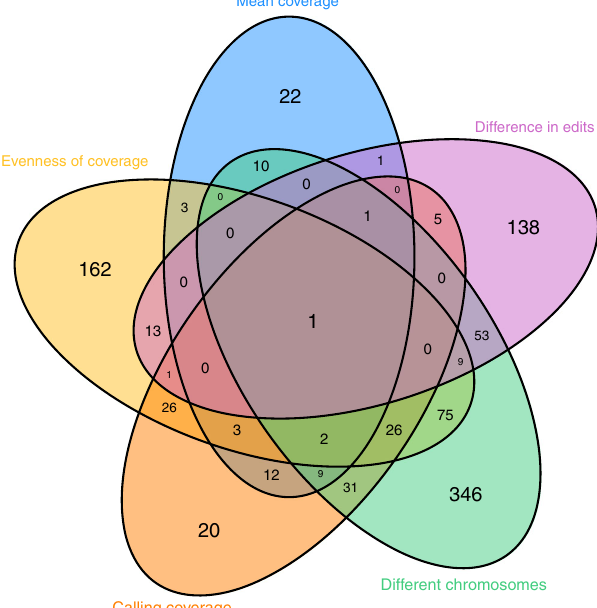
Fig. 2 Venn diagram showing for which QC measure sample pairs were penalised for. The outside numbers show the number of sample pairs which fail that QC measure uniquely. The intersections show the number of sample pairs that have failed more than one QC measure. Looking at these overlaps between QC measures, while some measures are closer to each other than others (failing the sample pairs in tandem), they all maintain a large degree of